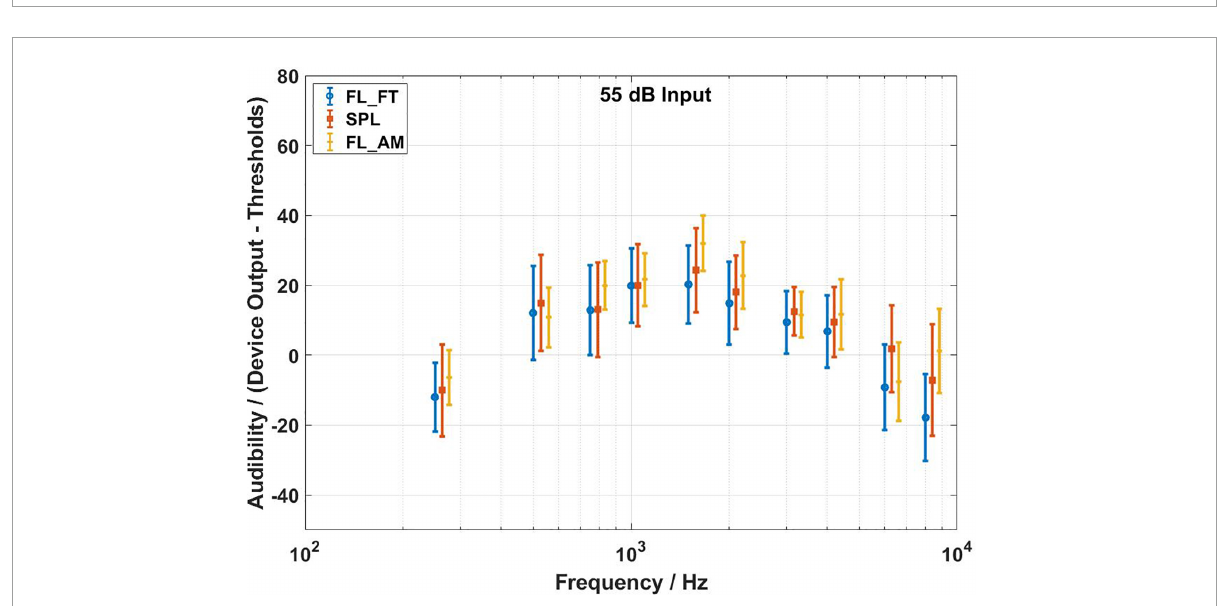
FIGURE7 Audibility estimates for the force transducer method, the ear canal method, and the artificial mastoid method at 55 dB SPL input level. Average values over all subjects. Error bars indicate ± 1 SD. The FL_FT indicates the force transducer method, the SPL indicates the ear canal method, and the FL_AM indicates the artificial mastoid